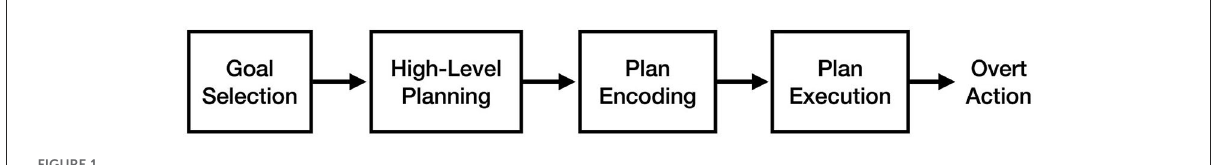
FIGURE1 The key stages of the motor execution process, based on Jeannerod